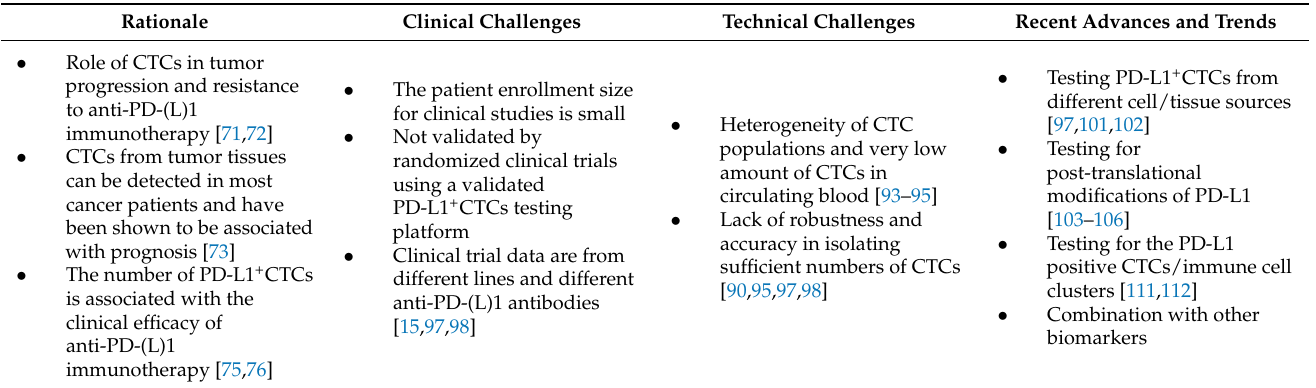
Table 1. Clinical and technical challenges in the use of PD-L1 + CTCs as a biomarker for anti-PD-(L)1